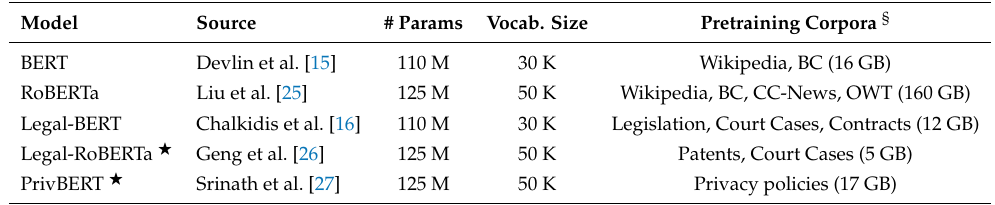
Table 2. Summary of models used in the PrivacyGLUE benchmark; all models used are